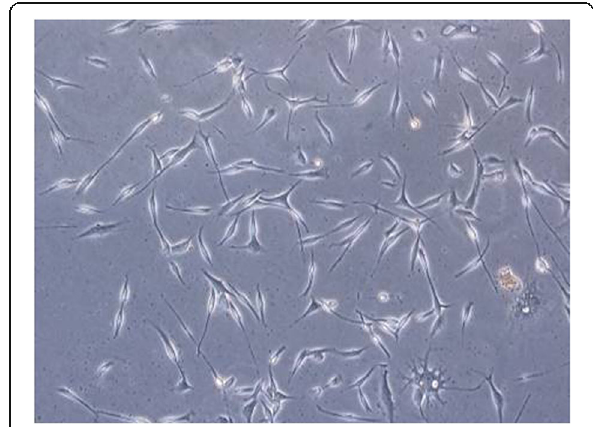
Fig. 1 Photomicrograph of DPSC illustrating an increase in the number of stem cells and spindle-shaped cells (magnification × 100)